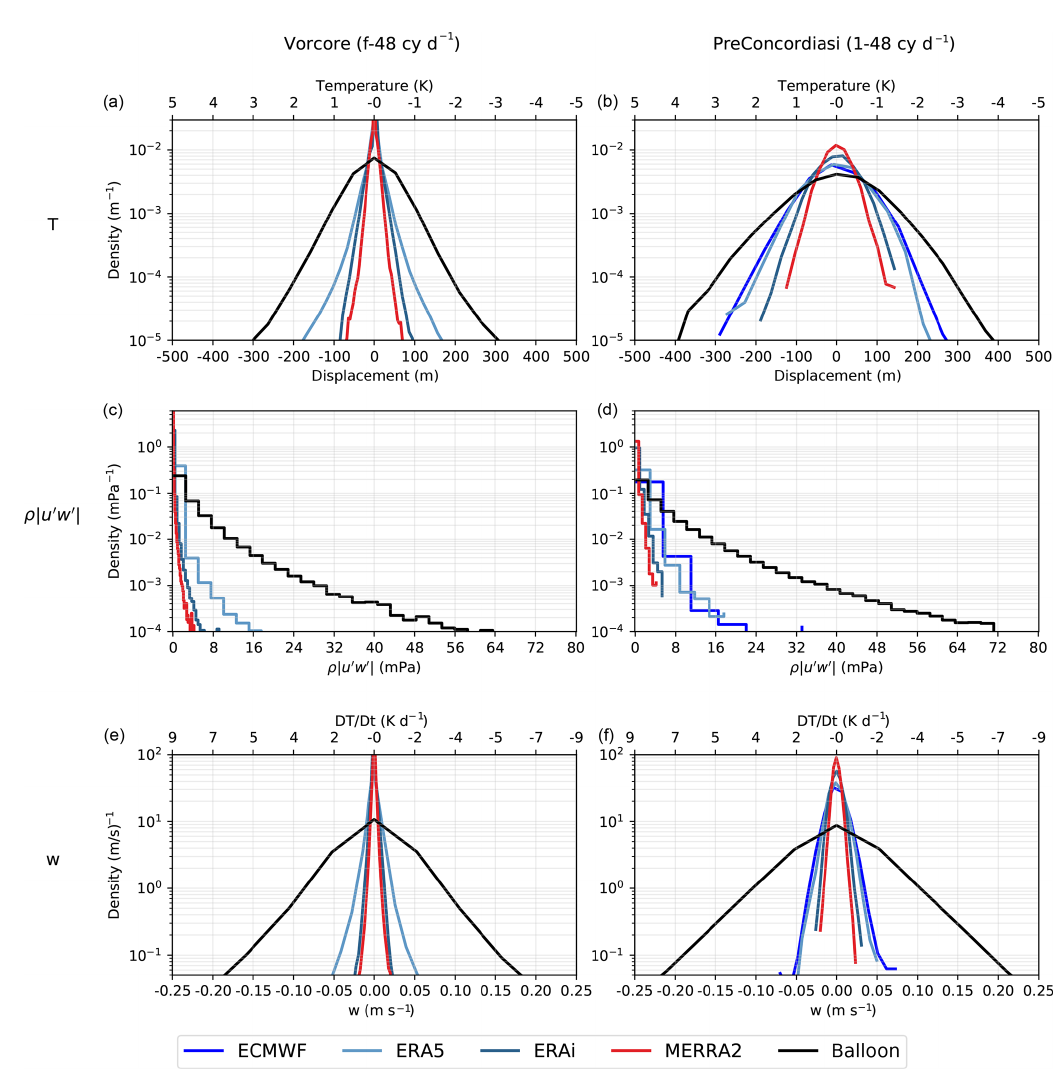
Figure 4. Probability density functions (PDFs) of (a, b) temperature fluctuations, (c, d) modulus of the zonal momentum flux and (e, f) vertical wind in the balloon observations (black) and in the different reanalyses (colors), for intrinsic frequencies between f and 48cyd − 1 ( a , c , e , pole) or between 1 and 48cyd − 1 ( b , d , f ,